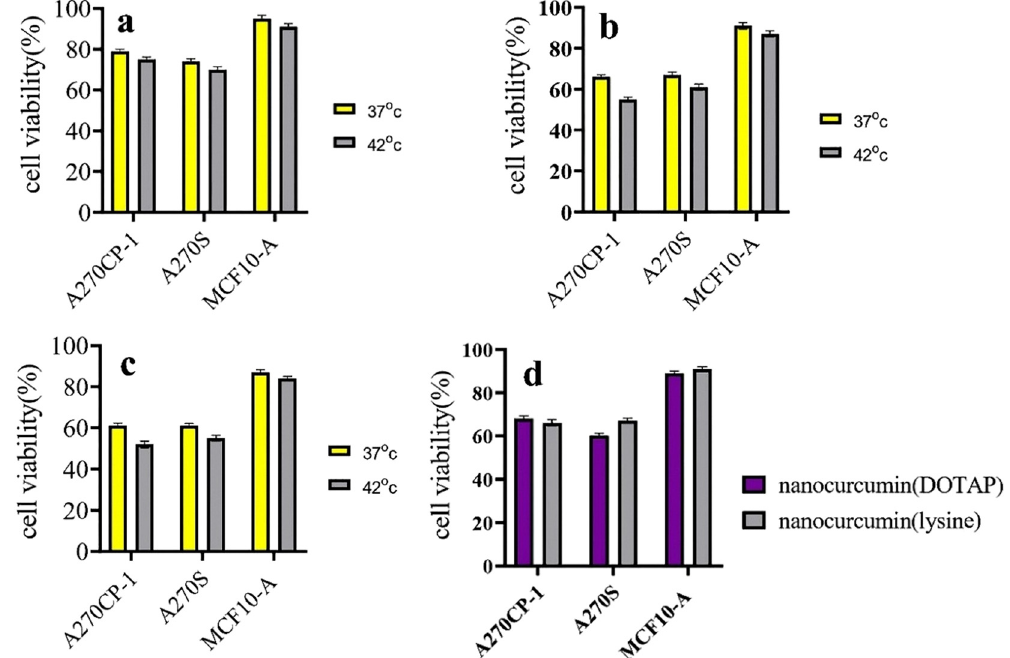
Figure 7: ( a ) The cell viability analysis of the modi fi ed niosomal NPs in cancerous and normal cells at 37 and 42°C for 24 h. ( b ) The cell viability analysis of the modi fi ed niosomal NPs in cancerous and normal cells at 37 and 42°C for 48 h. ( c ) The cell viability analysis of the modi fi ed niosomal NPs in cancerous and normal cells at 37 and 42°C for 72 h. ( d ) The cell viability analysis of the lysine - mediated niosomal NPs and the DOTAP - mediated niosomal NPs in cancerous and normal cells at 37°C for 48